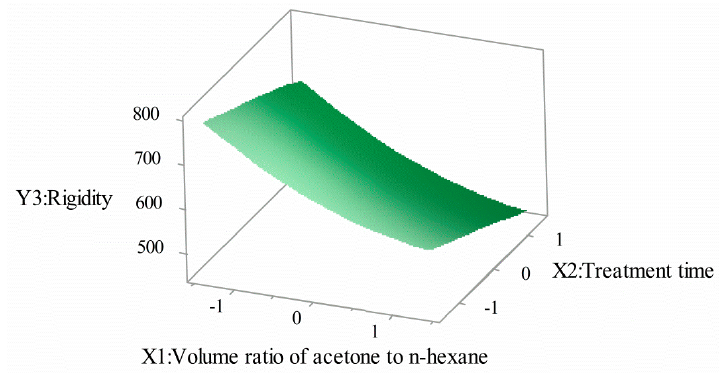
Figure 8. Volume ratio of acetone to n-hexane and treatment time for rigidity (3D).